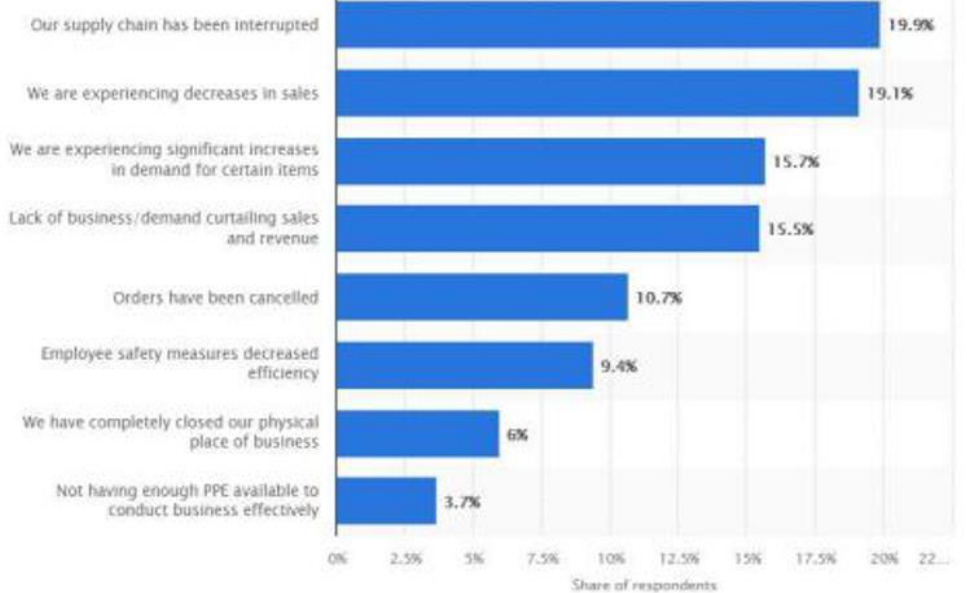
Figure 1. Key Challenges Posed by COVID-19 to Supply Chains